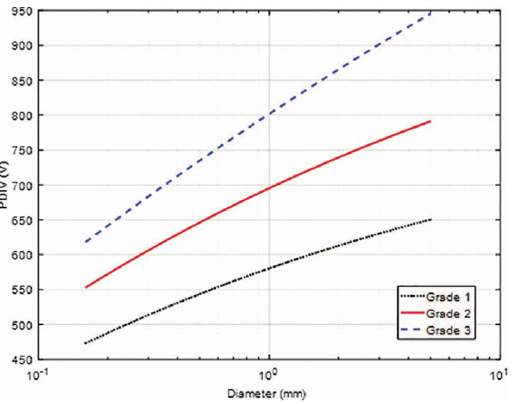
Figure 15. Worst case curves at ambient temperature (relative permittivity is equal to 4) [54].